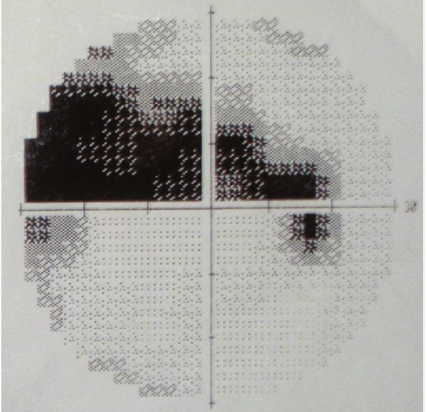
Figure 4: Example of the perimetric abnormalities analyzed by microperimetric test with both Mp-1 (interpolated map) and Humphrey 30-2